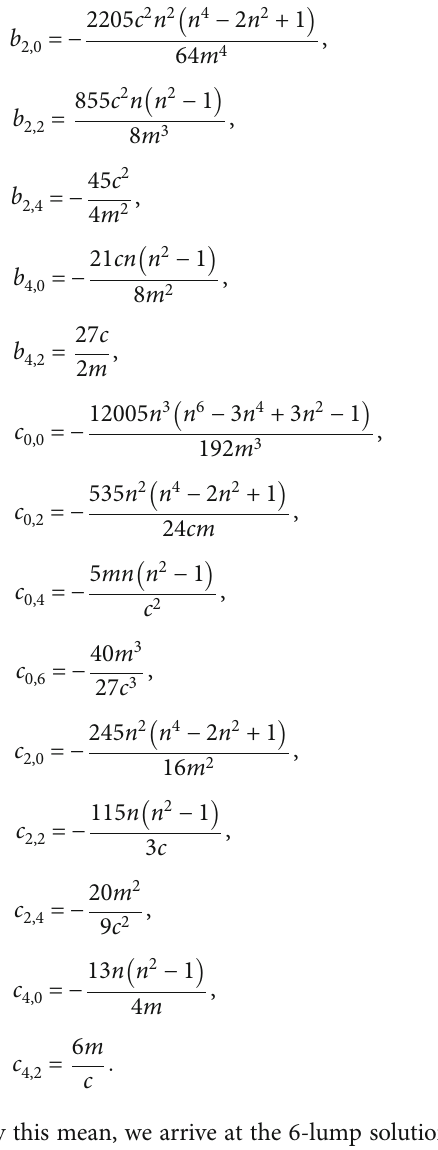
Figure 3: The 6-lump solution u of Equation (1) with the parameter selections m = − 2, n = 2, c = 1, u Perspective view of the wave u ð X , Z Þ , (b) overhead view of the wave u ð X , Z Þ , and (c) the corresponding contour plot u ð X , Z Þ